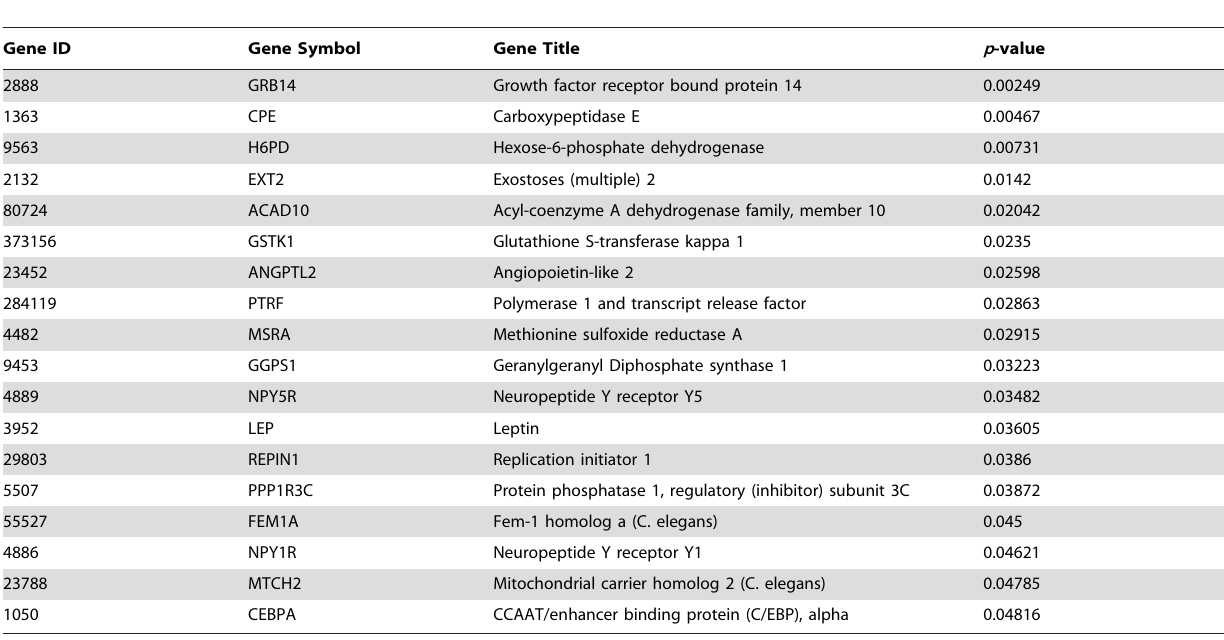
Table 2. Expression p-values for genes whose expression levels were positively correlated with weight